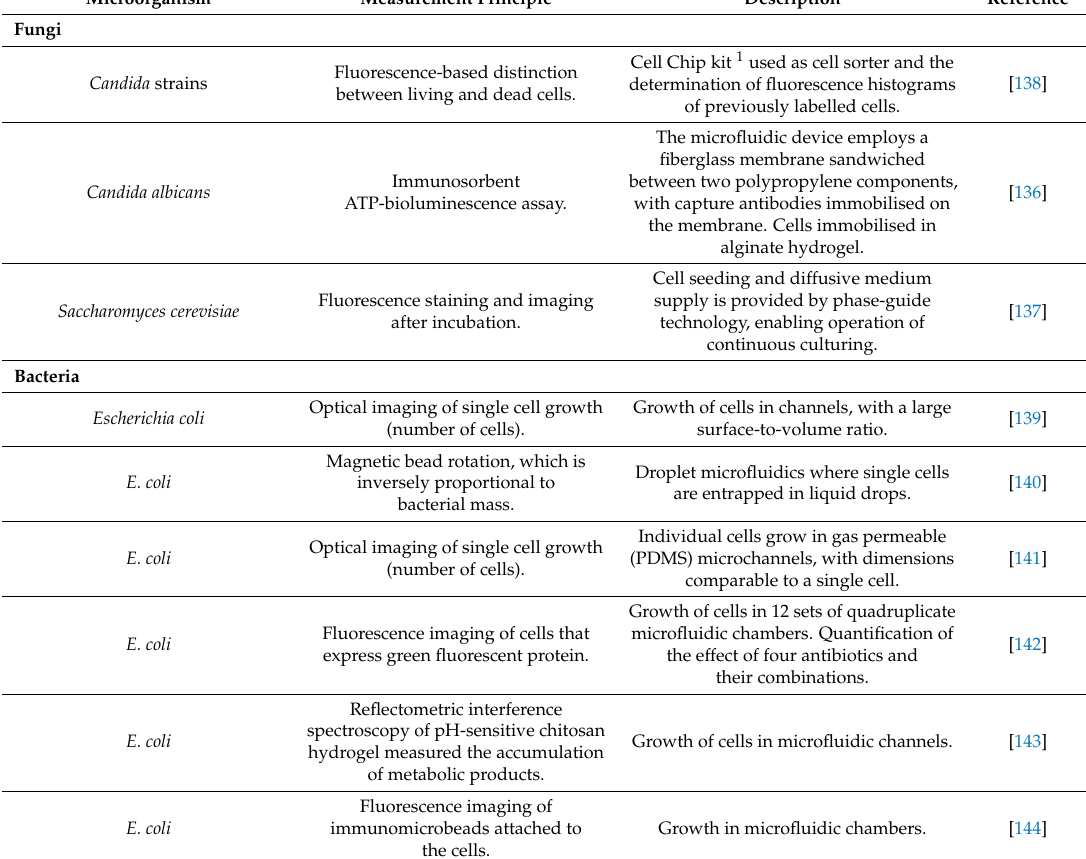
Table 3. Examples of microfluidic platforms for antimicrobial susceptibility